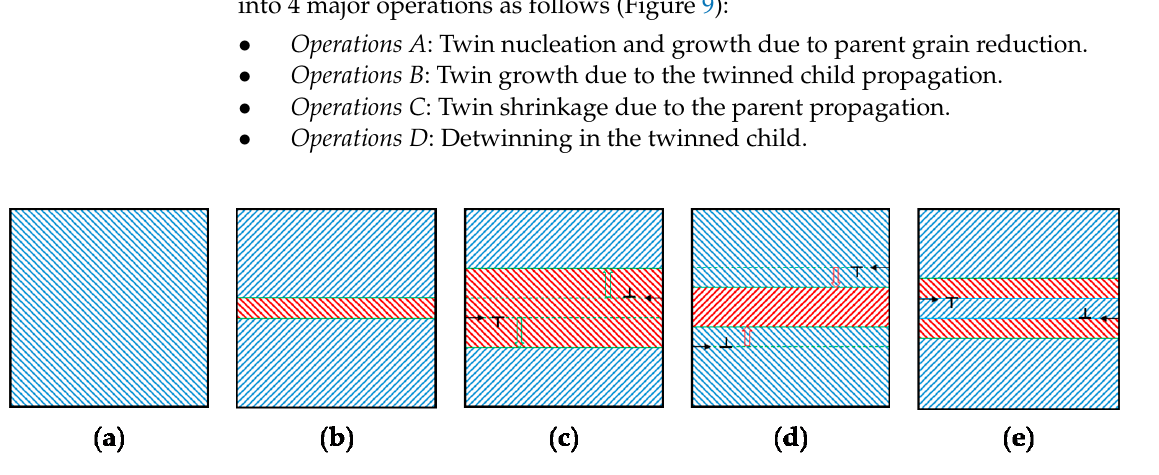
Figure 8. Comparison of the experimental and simulated response of the AZ31B Mg alloy during uniaxial loadings along the rolling direction. ( a ) Stress-strain curves of uniaxial tension and compression, ( b ) twin volume fraction of uniaxial compression (After Wu et al. [105]).